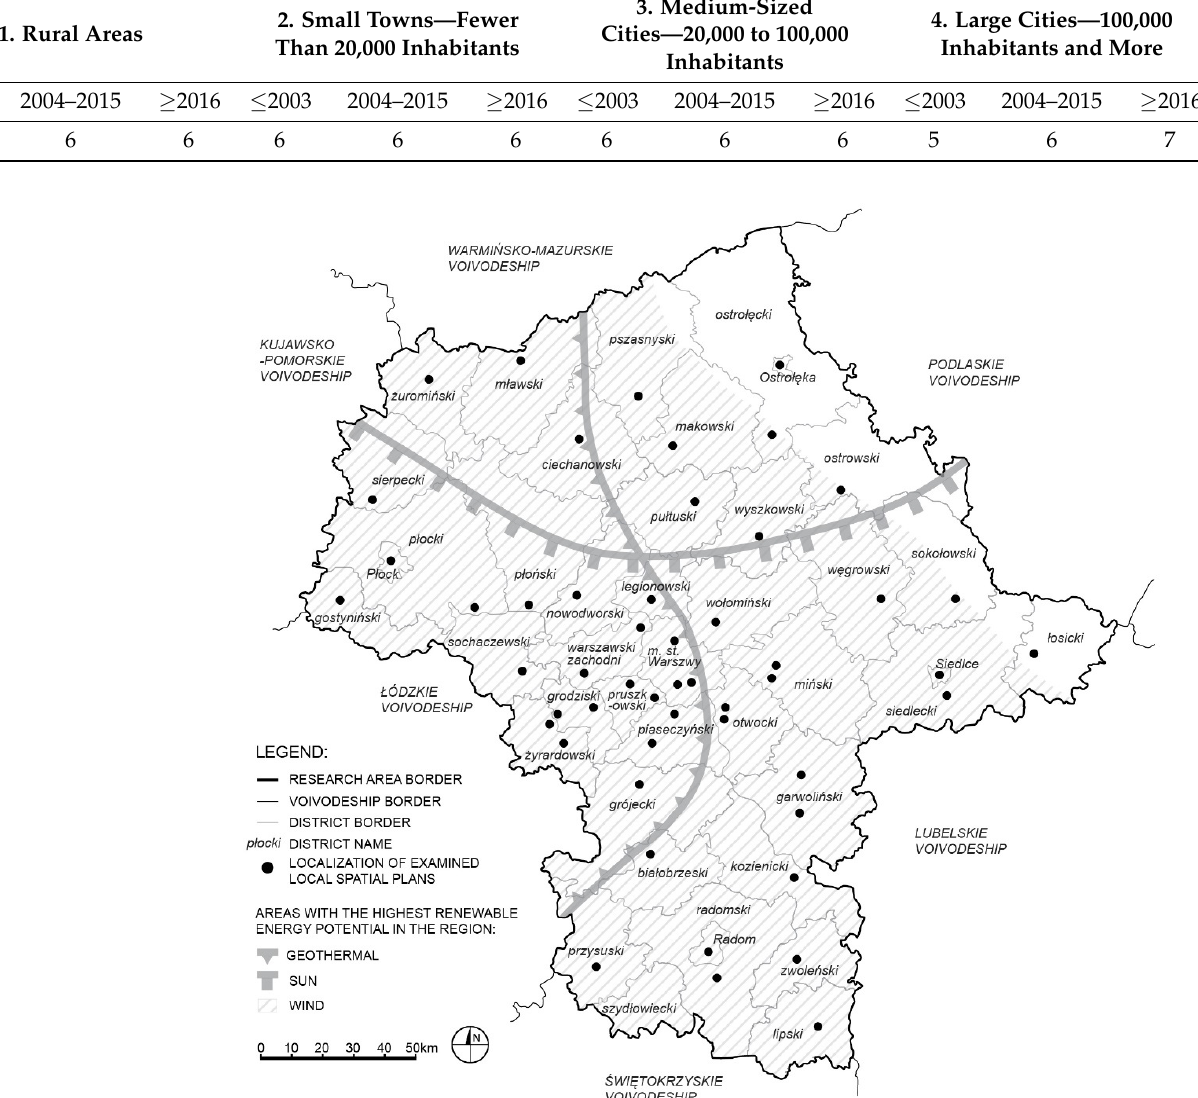
Figure 5. Location of the studied local plans in the Mazowieckie Voivodeship and individual poviats, showing the division into zones with different potential for the use of renewable energy. Source: own study.